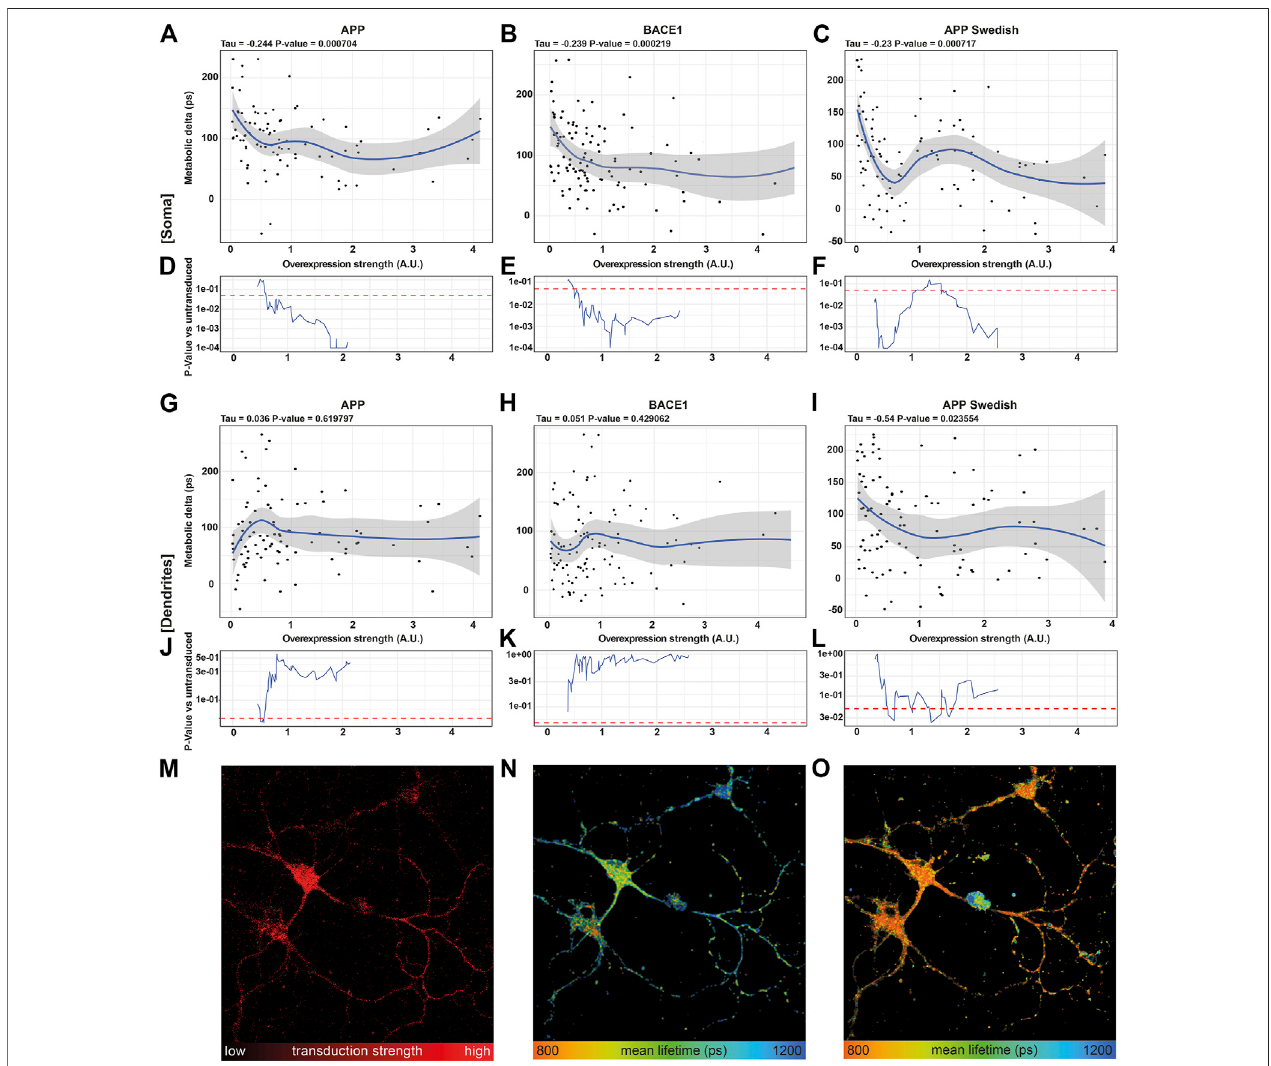
FIGURE 4 | NADH FLIM Metabolic Delta shows dose-mitochondrial respiration correlates with APPswe overexpression strength in a dose-dependent manner. (A – C, G – I) Correlations of the metabolic delta in somatic (A – C) and dendritic regions (G – I) with the overexpression strength of APP (soma: τ (cid:2) − 0.244, p (cid:2) 0.0007, dendrites τ (cid:2) 0.036, p (cid:2) 0.619,797), BACE1 (soma: τ (cid:2) − 0.239, p (cid:2) 0.0002, dendrites: τ (cid:2) − 0.051, p (cid:2) 0.429,062), and APPswe (soma: τ (cid:2) − 0.231, p (cid:2) 0.0007, dendrites: τ (cid:2)− 0.54, p (cid:2) 0.023,554),quanti fi edasmCherry fl uorescenceintensityofAPP (A) ,BACE1 (B) ,andAPPswe (C) neuronsonthesingle-celllevel(n (cid:2) 5, > 120neurons).Thebluelinerepresentsalocalregression(loess)curvetovisualizethenonlinearregression. (D – F,J – l) Signi fi canceindicatedas p -value[p]vs.the21least transduced neurons was evaluated using a sliding window and a permutation test and plotted in (D – F, J – O). A representative image section of BACE1 neurons underliningthedecreaseinthemetabolicdeltawithincreasingoverexpressionstrength. (M) OverexpressionstrengthisdisplayedasthemCherry fl uorescenceintensity. NADH FLIM before (N) and after AA treatment (O) are false-color coded with the corresponding color palette shown below.